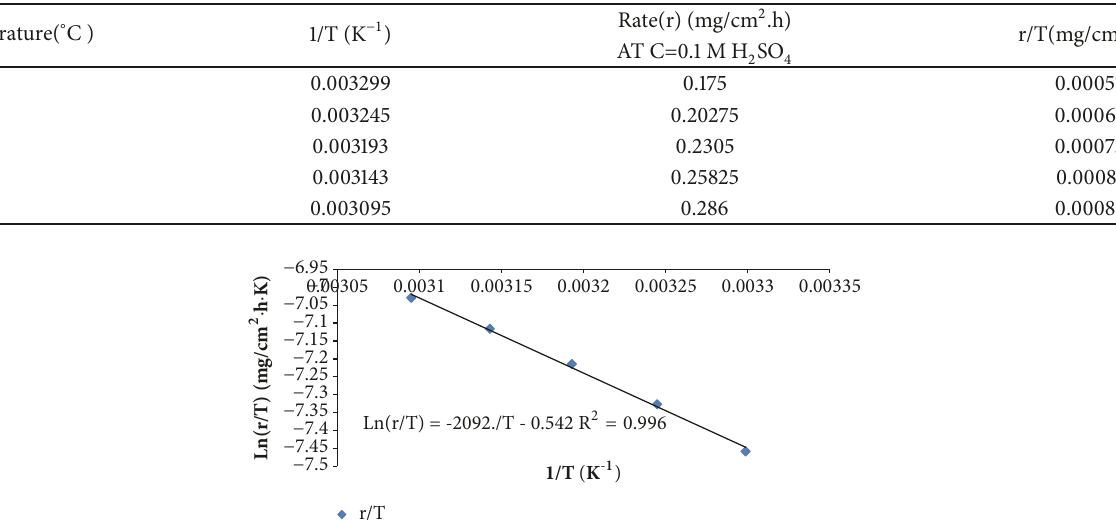
Figure 1: Log(r/T) versus (1/T) of mild steel in sulfuric acid at (0.1 M) concentration and at different temperature (30–50 ∘ C).